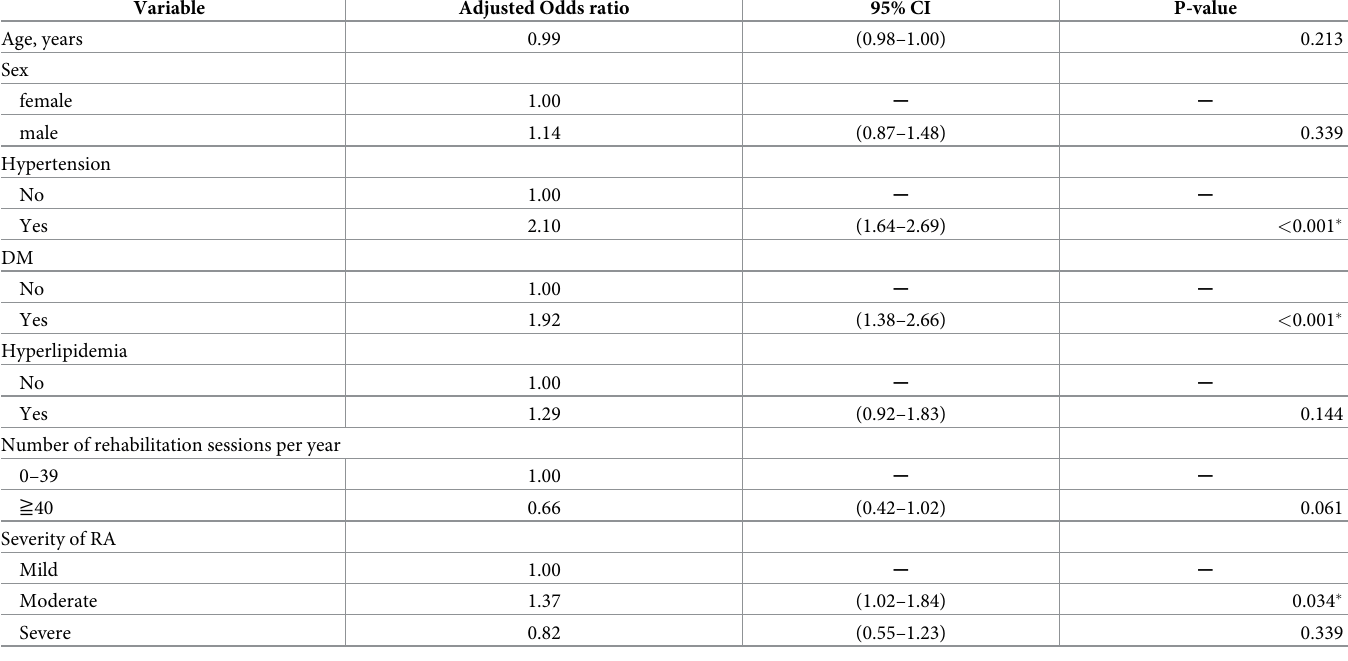
Table 2. Adjusted odds ratios of stroke for age, sex, hypertension, DM, hyperlipidemia, number of rehabilitation per year, and severity of RA in the multivariable logistic regression analysis.